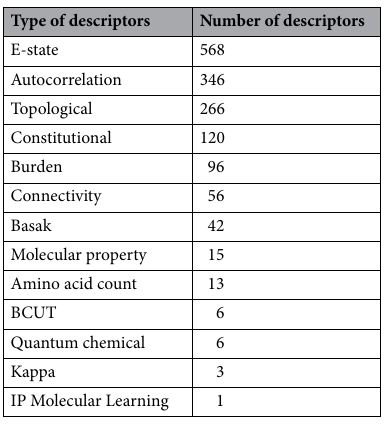
Table 1. Features of PaDEL descriptors used in this